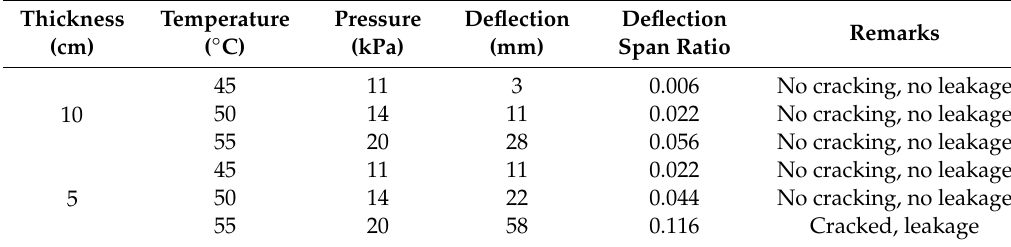
Table 6. Model test